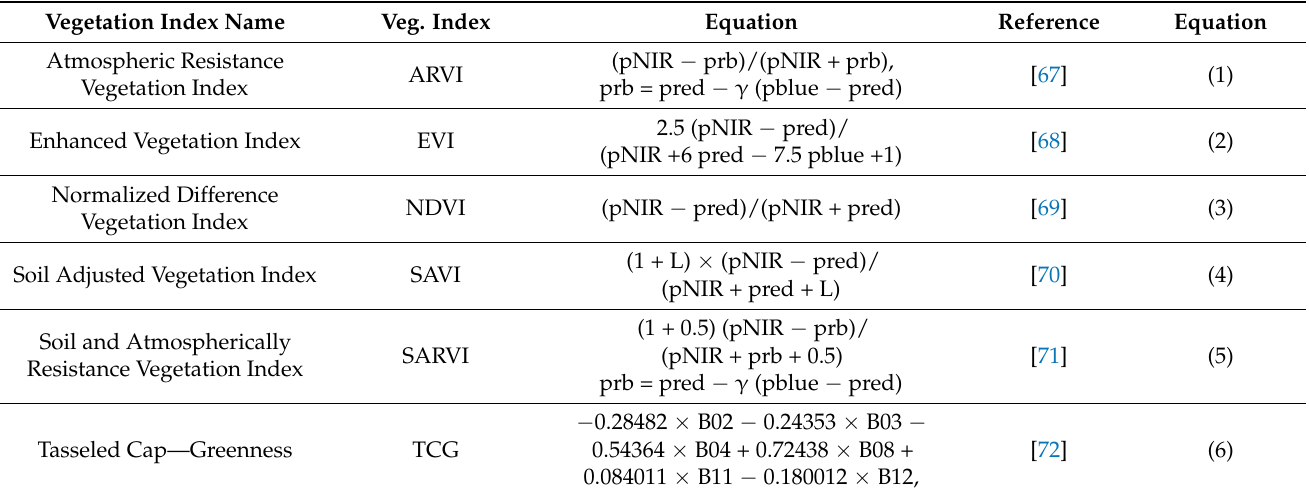
Table 1. Linear correlation coefficient of the four areas using the ARVI profiles.